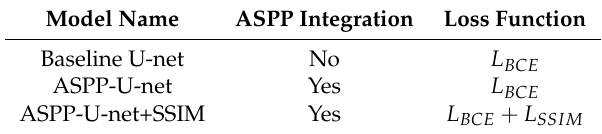
Table 1. The network configuration of the three compared